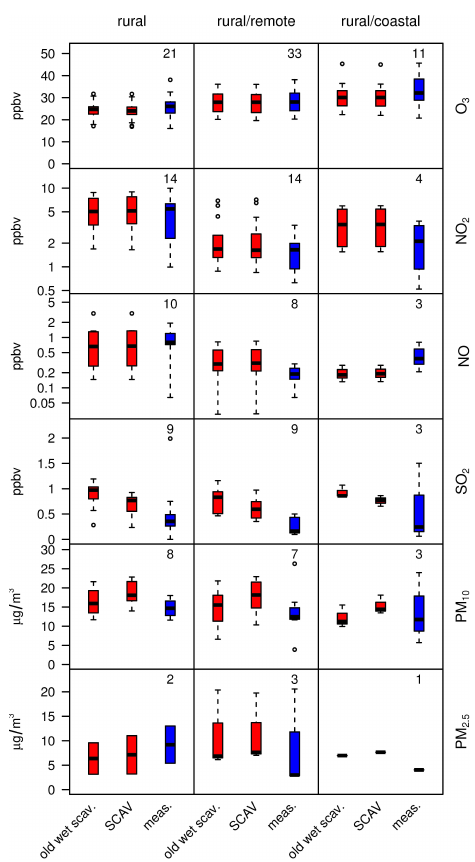
Fig. 4. Boxplots of mean trace gas and particulate matter concen- trations of a set of measurement stations averaged over the simu- lation period. Shown are results from the reference simulation in Knote et al. (2011) (REF), results from a new simulation including aqueous-phase chemistry (SCAV), and measurement data from the EMEP network (meas.). Stations classified according to their rep- resentativeness following (Henne et al., 2010). Number of stations used shown in top-right